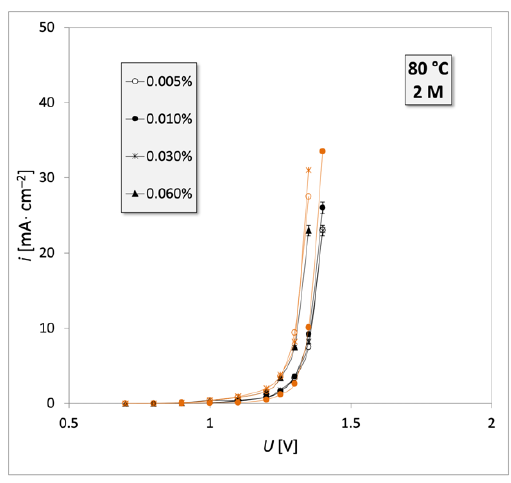
Figure 9. Electro-oxidation curves of Syntanol DS-10 detergent (orange lines) and waste engine oil emulsion (black lines) at the temperature of 80 °C in a 2 M aqueous solution of H 2 SO 4 , for various concentrations of detergent and emulsion (0.005%, 0.010%, 0.030%, and 0.060% of reactor volume).